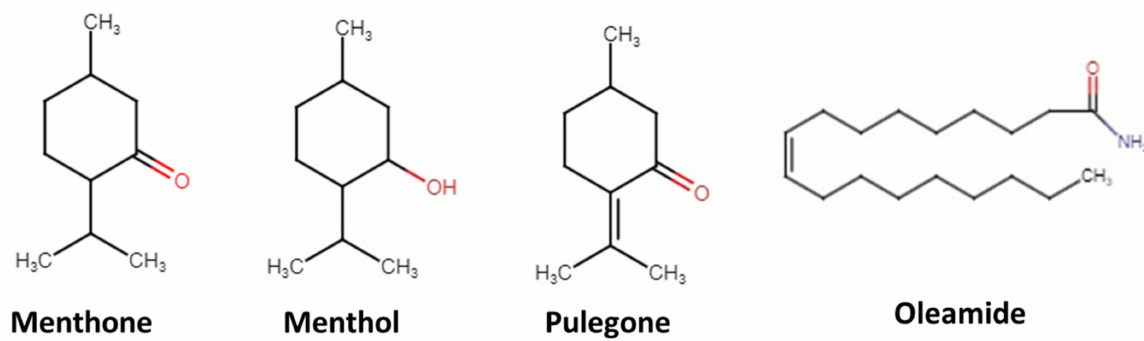
Figure 1. Chemical structure of the main bioactives in Micromeria fruticosa